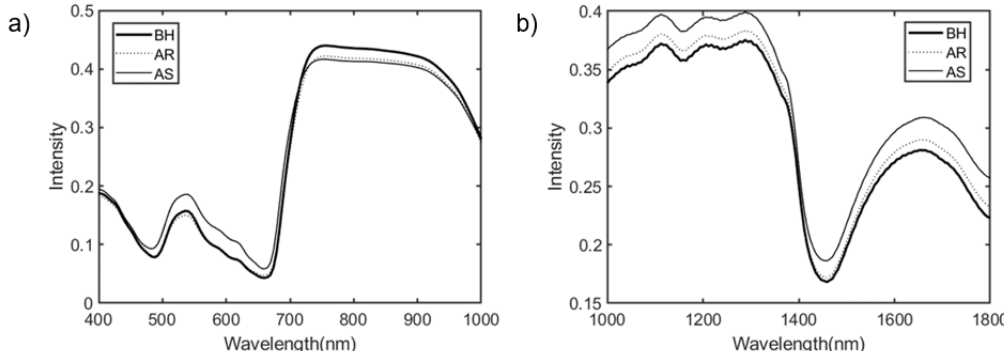
Figure 3. Averaged spectra of Vis/NIR ( a ) and SWIR ( b ) of control and stressed ginseng plants. BH, before exposed to heat stress; AR, after exposed to heat stress group about resistibility; AS, after exposed to heat stress group about susceptibility.